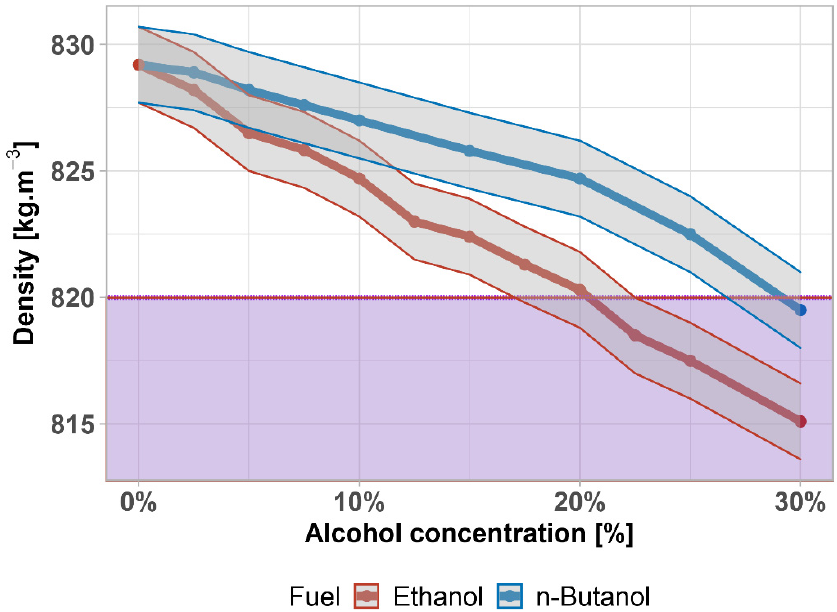
Figure 6. Density of diesel fuel–alcohol mixtures. Purple area highlights exceeding the limit given by the standard.